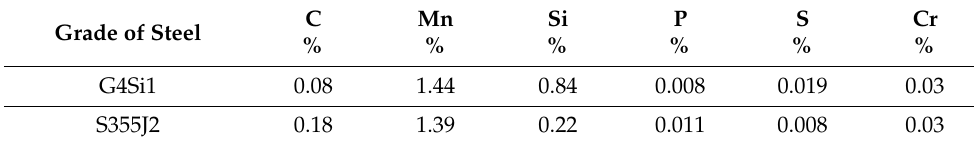
Table 1. Chemical composition of tested